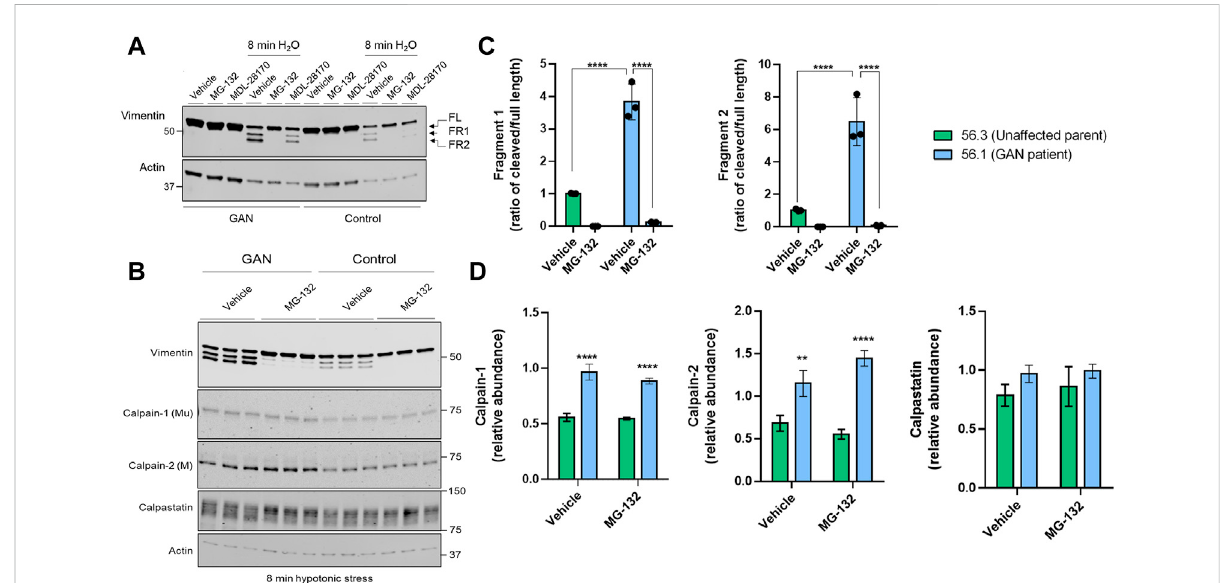
FIGURE 3 Vimentin cleavage is blocked by inhibitors of the proteasome and calpains, which are elevated in GAN. (A) Immunoblotting for vimentin (top) andactin(bottom;loadingcontrol)inTritonXinsolublepelletfractionsfromuntreated(lanes1 – 3,7 – 9)orwater-exposed(lanes4 – 6,10 – 12)control 56.3 and GAN 56.1 fi broblasts in the absence or presence of the DMSO vehicle control, calpain inhibitor (MDL-28170), or calpain/proteasome inhibitor(MG-132).NotepartialcleavageinhibitionbyMDLandnear-completeinhibitionbyMG-132. (B) Immunoblottingforvimentin(top)and actin (bottom; loading control) in reduced Triton X insoluble fractions and for calpain-1 (middle top), calpain-2 (middle), and calpastatin (middle bottom) in reduced Triton X soluble fractions from GAN and control fi broblasts exposed to 8 min of hypotonic stress and treated with the DMSO vehicle control or MG-132. Shown are technical replicates from an individual experiment. The experiment was independently repeated at least 3 times. (C) Quanti fi cation of the relative fragment 1 (FR1) and fragment 2 (FR2) band intensities normalized to the full length vimentin band for each cell line (GAN 56.1 fi broblasts; control 56.3 fi broblasts) and treatment group (from panel B). **** p < 0.0001; two-way ANOVA. (D) Quanti fi cation of calpain-1, calpain-2, and calpastatin levels (from panel B). ** p < 0.01; **** p < 0.0001; two-way